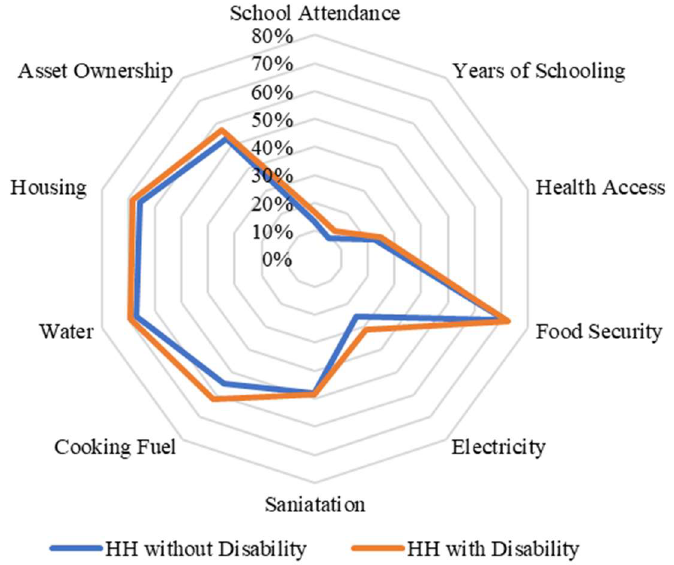
Figure 5. Censored headcount ratios for households with and without members with disability in the highest quintile in Nigeria.